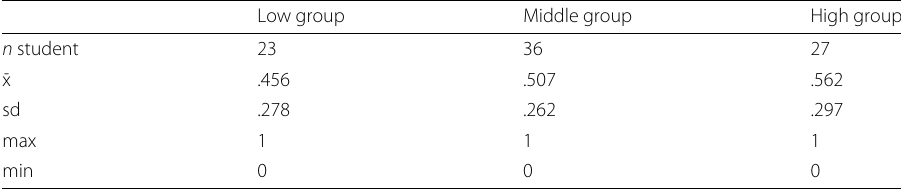
Table 8 Descriptive statistics of item difficulty P for proficiency-based groups Low group Middle group High group